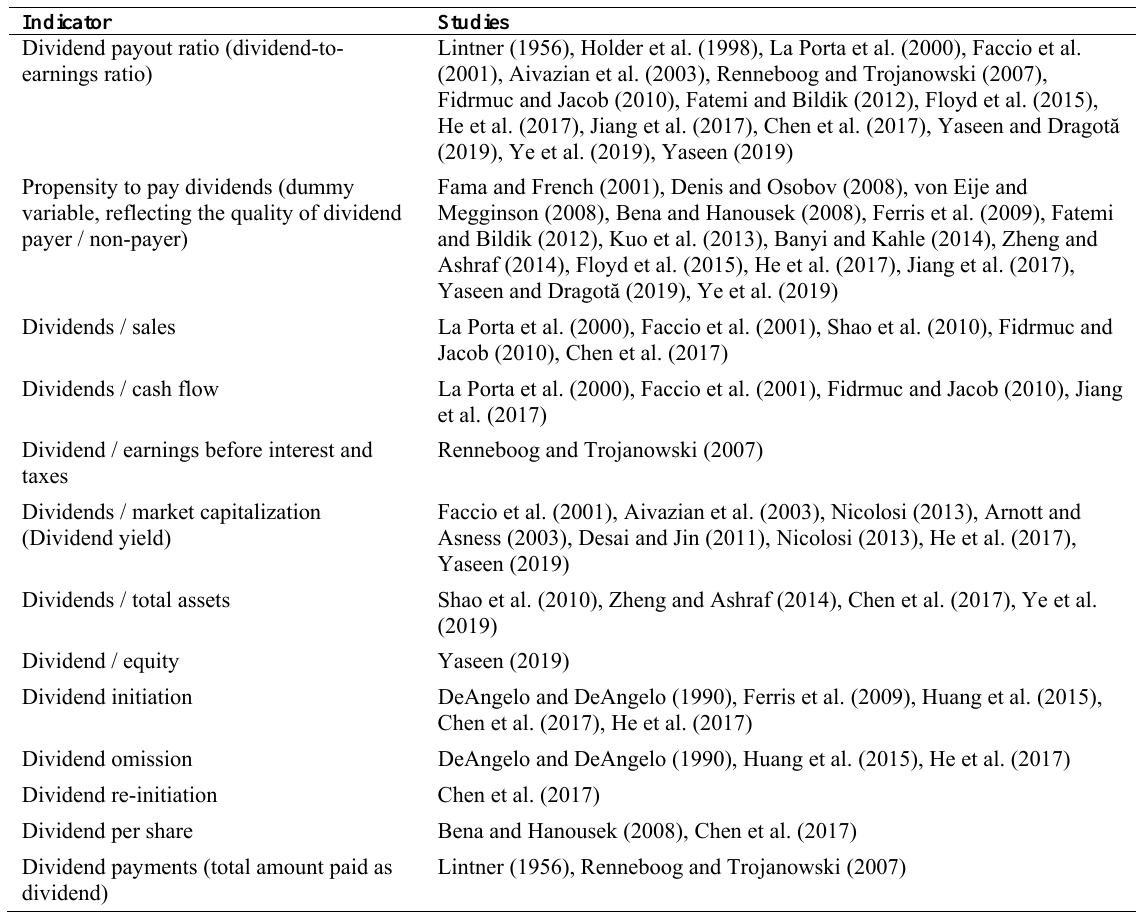
Table 1 : Indicators used in modelling dividend